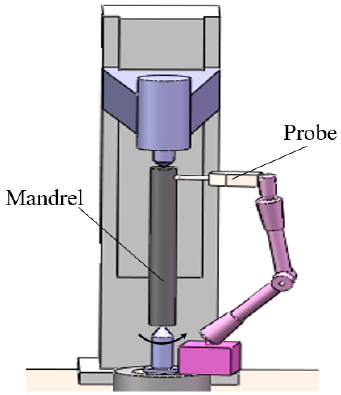
Figure 5. Measurement of coaxial error of the mandrel to the spindle.